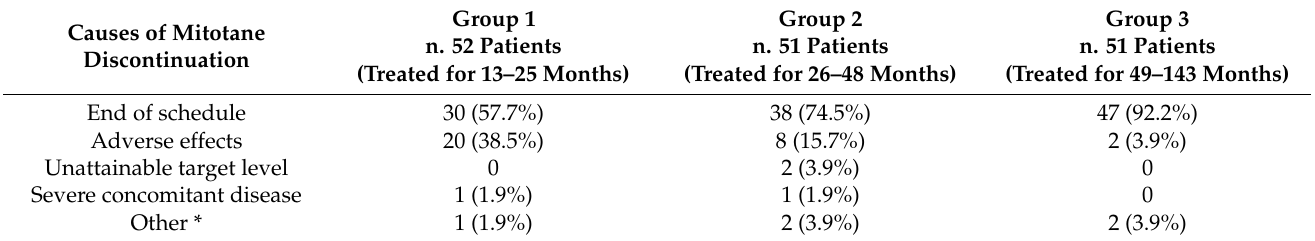
Table 3. Causes of mitotane discontinuation in different groups stratified by duration of therapy. Causes of